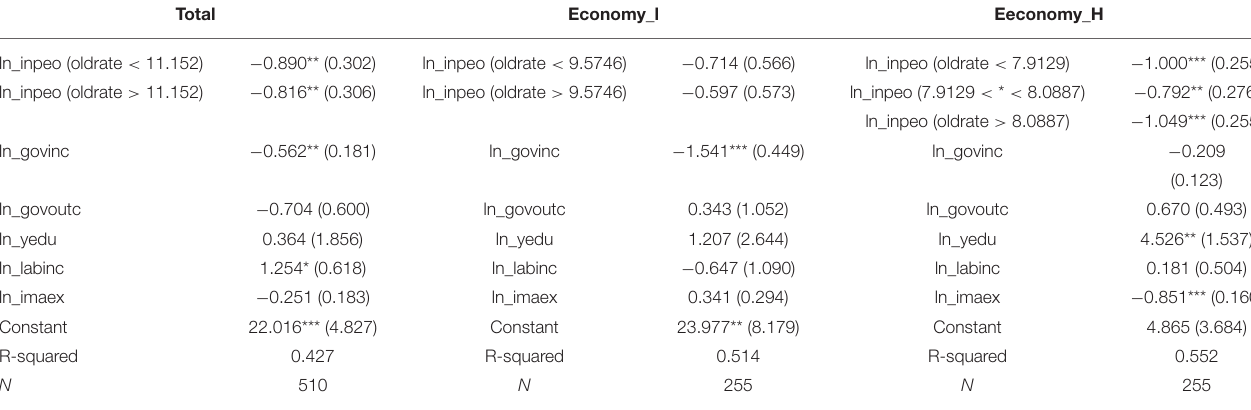
TABLE 6 | Estimated coefficients.